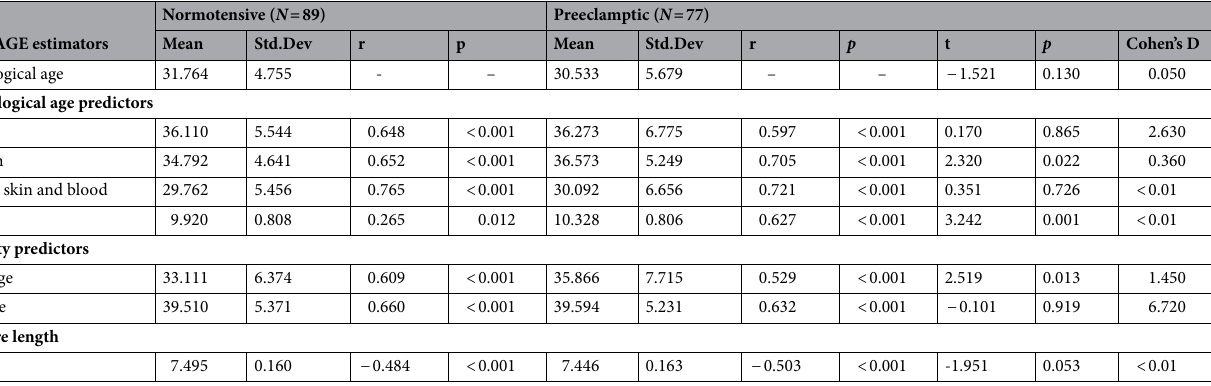
Table 2. Pearson’s correlations and independent t-tests between average DNAm_age estimators among investigated